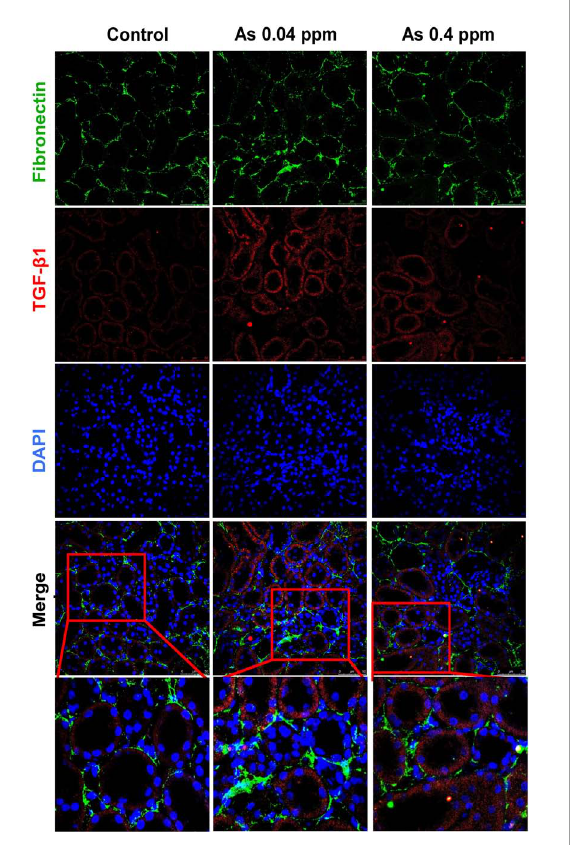
FIGURE11 Collagen deposition corresponds with increased fibronectin expression in the medullary region of the kidney. Kidney sections of exposed animals were stained at 38 weeks of age. Increased fibronectin and TGF- β 1 expression were observed in the medullary region. Bar = 25 µ